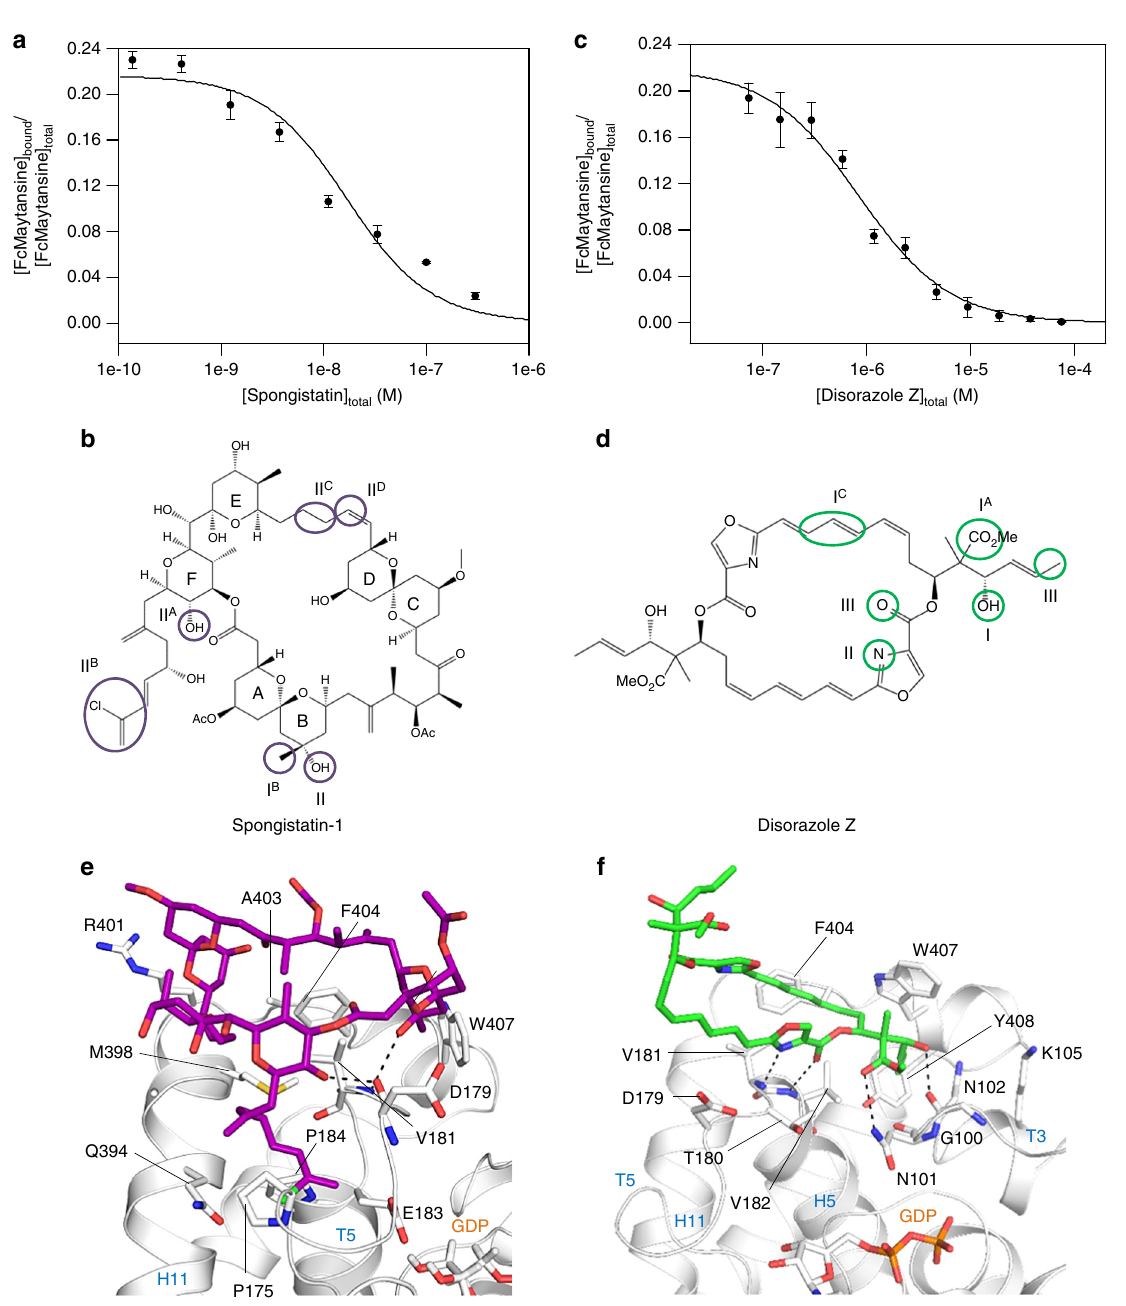
Fig. 4 Spongistatin-1 and disorazole Z are maytansine-site ligands. a , c Displacement assays for spongistatin-1 ( a ) and disorazole Z ( c ). The data are from three independent experiments and represent mean ± SEM. The solid lines represent fi ts to the data (see Methods). b , d Molecular structures of spongistatin-1 ( b ) and disorazole Z ( d ). The tubulin-interacting parts of the molecules are depicted with purple (spongistatin-1) and green (disorazole Z) circles. The main interacting residues are labeled in black and hydrogen bonds are represented by black broken lines. Secondary structure elements are depicted in blue. e , f Close-up views of the interaction mode between spongistatin-1 and tubulin ( e ) and between disorazole Z and tubulin ( f ). The β -tubulin subunit is represented in light gray cartoon representation and interacting residues are labeled in black. Spongistatin-1 and disorazole Z are shown in purple and green sticks representation, respectively. Oxygen, nitrogen and sulfur atoms are colored in red, blue and yellow and hydrogen bonds are represented with black broken lines. GDP molecule is shown in orange spheres representation. Secondary structural elements are labeled in